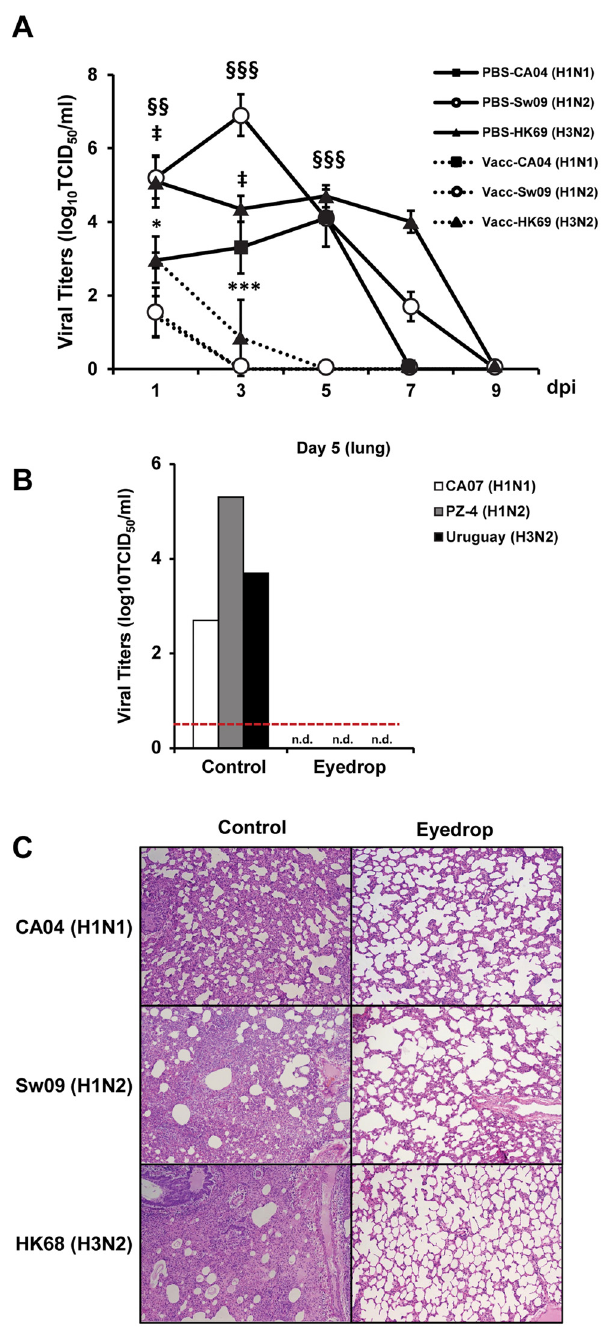
Fig 3. Successful viral clearance by eyedrop influenza vaccination. After intranasal challenge with CA04 (H1N1) or Sw09 (H1N2) or HK68 (H3N2), viral titers in nasal secretion samples taken at 9 dpi (A) or homogenized lung tissues at 5 dpi (B) were measured by plaque assay. Half of all mock or vaccinated ferrets in each group were sacrificed at 5 dpi for the lung tissue preparation (n = 3 for each group). (C) Hematoxylin- and eosin-stained sections of lung tissue collected from: CA04 (H1N1; Top panels) or Sw09 (H1N2; Middle panels) or HK68 (H3N2; Bottom panels) challenged ferrets. Left panels, PBS administered ferrets (HI titer < 20); right panels, eyedrop vaccinated ferrets (HI titer (cid:3) 40). Magnification 200×. * p < 0.05, *** p < 0.001 compared with the findings in the CA07 (H1N1) LAIV-vaccinated and CA04 (H1N1) challenged group; §§ p < 0.01, §§§ p < 0.001 compared with findings in the PZ-4 (H1N2) LAIV-vaccinated and Sw09 (H1N2) challenged group; ‡ p < 0.05 compared with the findings in the Uruguay (H3N2) LAIV-vaccinated and HK69 (H3N2) challenged group. i.n., intranasal, n.d., non-detected.